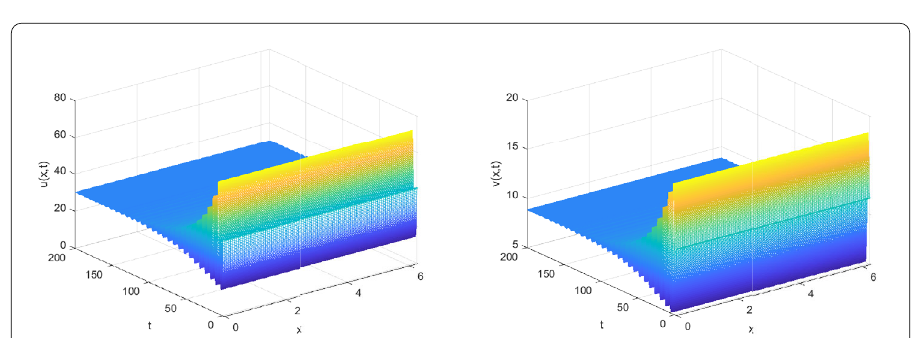
Figure 8 τ = 2 < τ 0 0 and the initial condition is (40.87,11.68). P ∗ = ( u ∗ , v ∗ ) is locally asymptotically stable